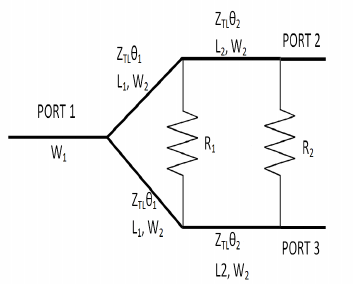
FIGURE 1. Equivalent circuit of dual band power divider